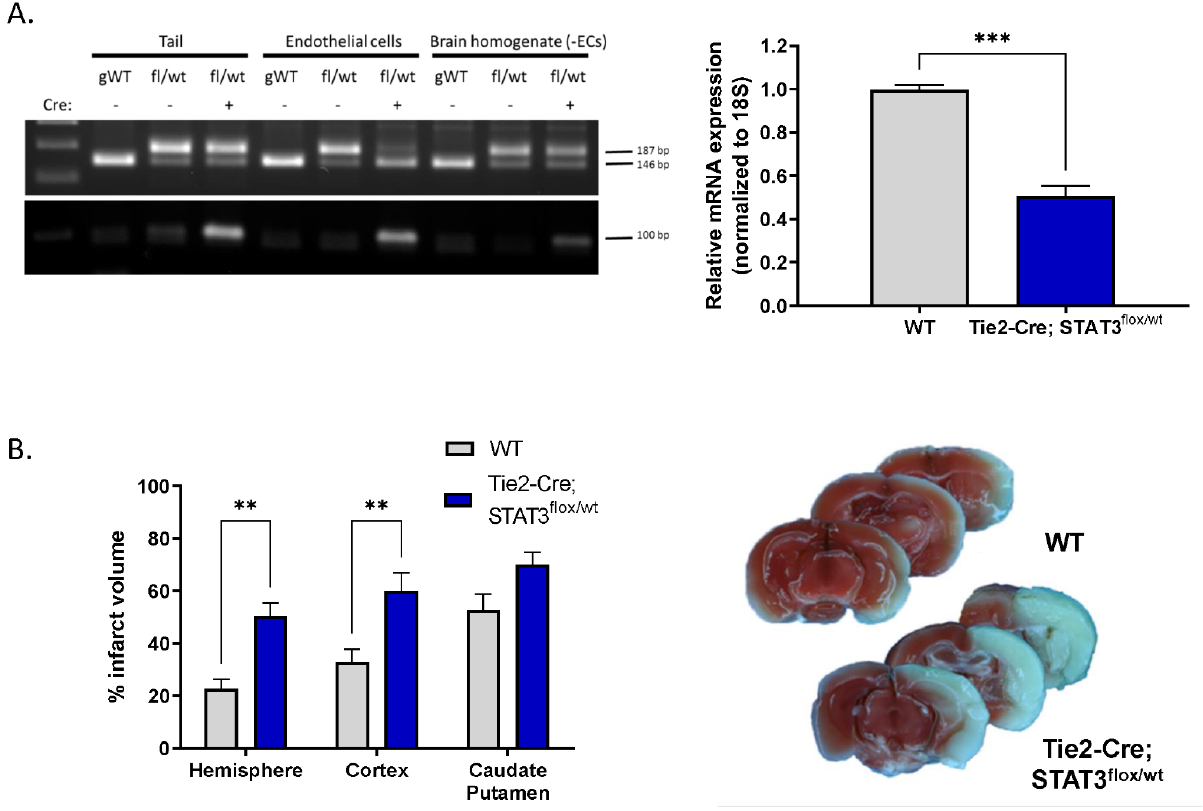
Figure 5. Increased infarct in mice with attenuated endothelial STAT3. ( A ) Cre-mediated attenua- tion of STAT3 gene in ECs. Left, PCR analysis for WT and floxed STAT3 alleles in DNA isolated from tail, acutely isolated brain ECs, and the remaining brain homogenate minus the extracted ECs from genetically wild-type (gWT), STAT3 flox/wt and Tie2-Cre; STAT3 flox/wt mice. Amplification of wild-type allele results in a 146 bp fragment; amplification of the floxed allele, containing the loxP sites generates a 187 bp band. Genotyping for the Tie2-Cre allele is also shown; amplification of the Cre transgene results in a 100 bp band. Right, ECs from Tie2-Cre; STAT3 flox/wt mice have lower STAT3 mRNA levels compared to ECs from STAT3 flox/wt control littermates (WT), measured by Taq- Man quantitative real time PCR. n = 3; ***, p < 0.001, t -test. ( B ) Tie2-Cre; STAT3 flox/wt and WT mice were subjected to 60 min MCAO, infarct was assessed TTC labeling after 24 h reperfusion, repre- sentative brain slices are shown. Mice with conditionally attenuated STAT3 in ECs (Tie2-Cre; STAT3 flox/wt ) displayed larger hemispheric infarct following MCAO compared to WT littermates. n = 8 WT, n = 6 Tie2-Cre; STAT3 flox/wt ; **, p < 0.01, 2-way ANOVA. Data are presented as mean ± SEM.